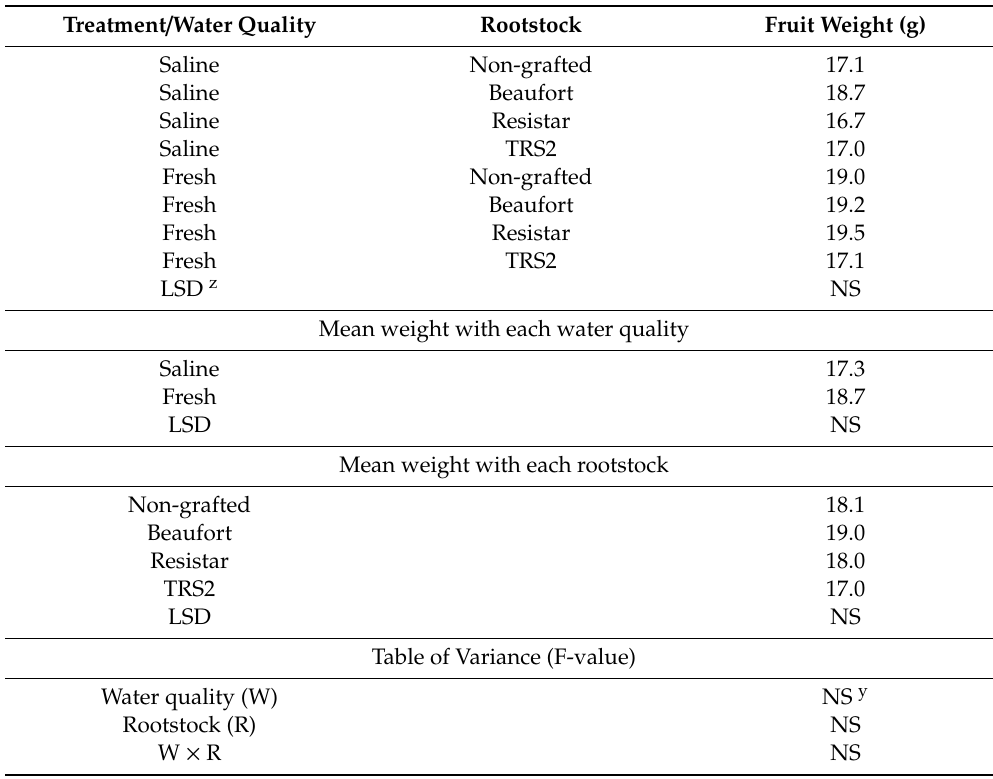
Table of Variance